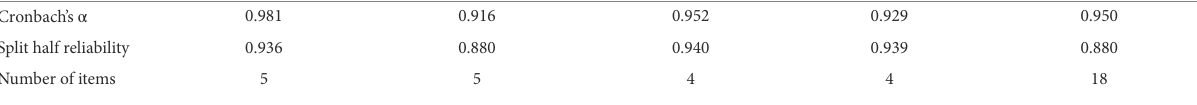
TABLE 5 Reliability analysis.